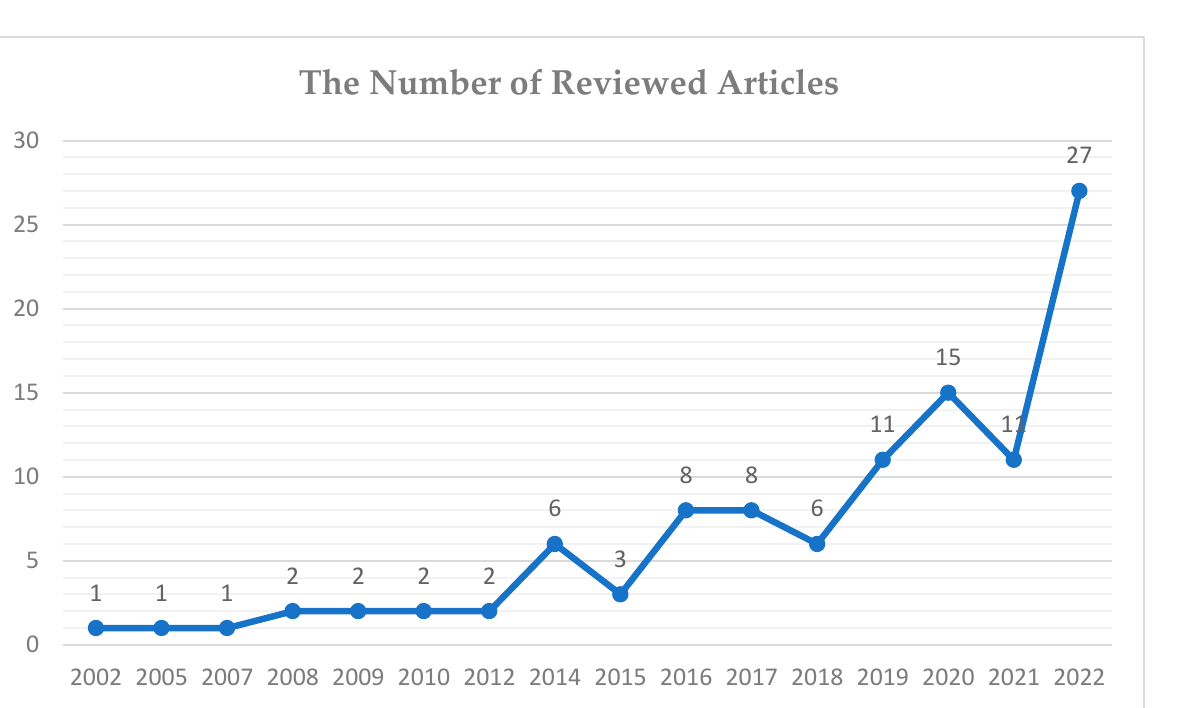
Figure 3. The Number of Reviewed Articles Published Per Year.